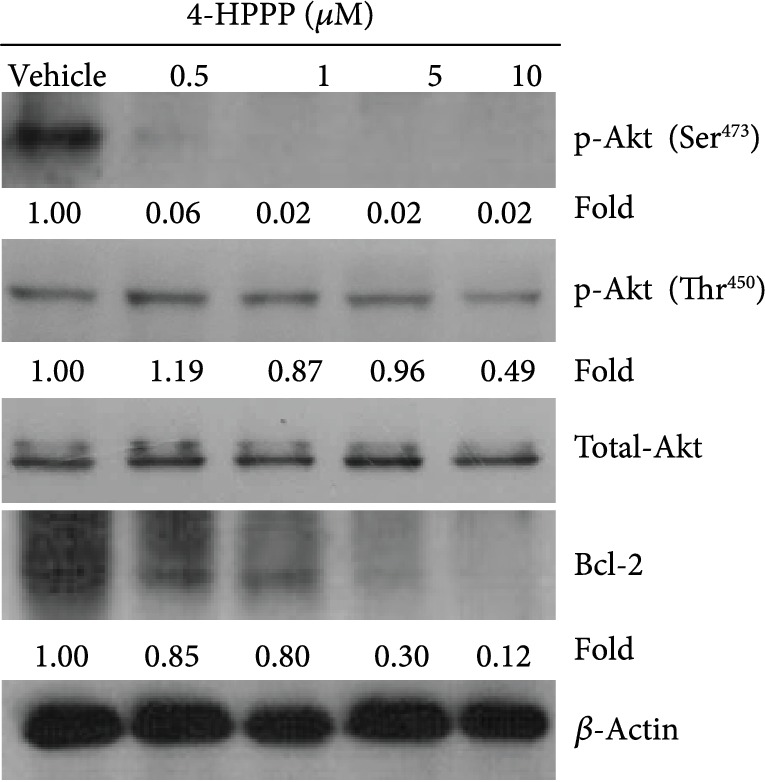
The effect of 4-HPPP on Akt phosphorylation changes in NSCLC cells. The phosphorylation changes at serine473 and threonine450 of Akt along with the prosurvival factor Bcl-2 were assessed using the Western blotting assay. β-Actin was used as an internal control to ensure equal loading.